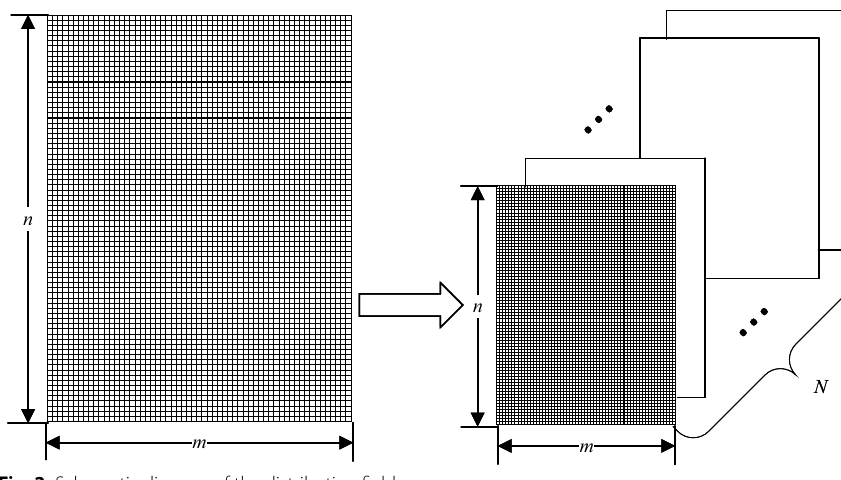
Fig. 2 Schematic diagram of the distribution